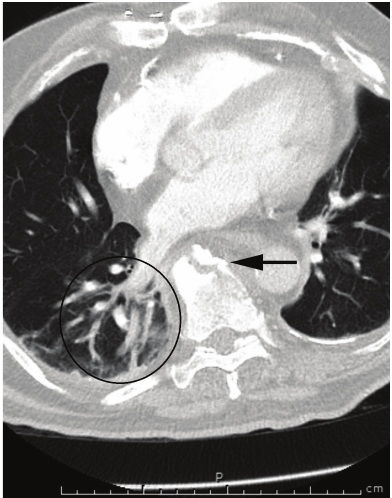
Figure 1: Axial CT angiogram of the chest showing a T8 vertebral fracture ( arrow ) and lung hemorrhage or possible contusion in the right lung base ( black circle ).